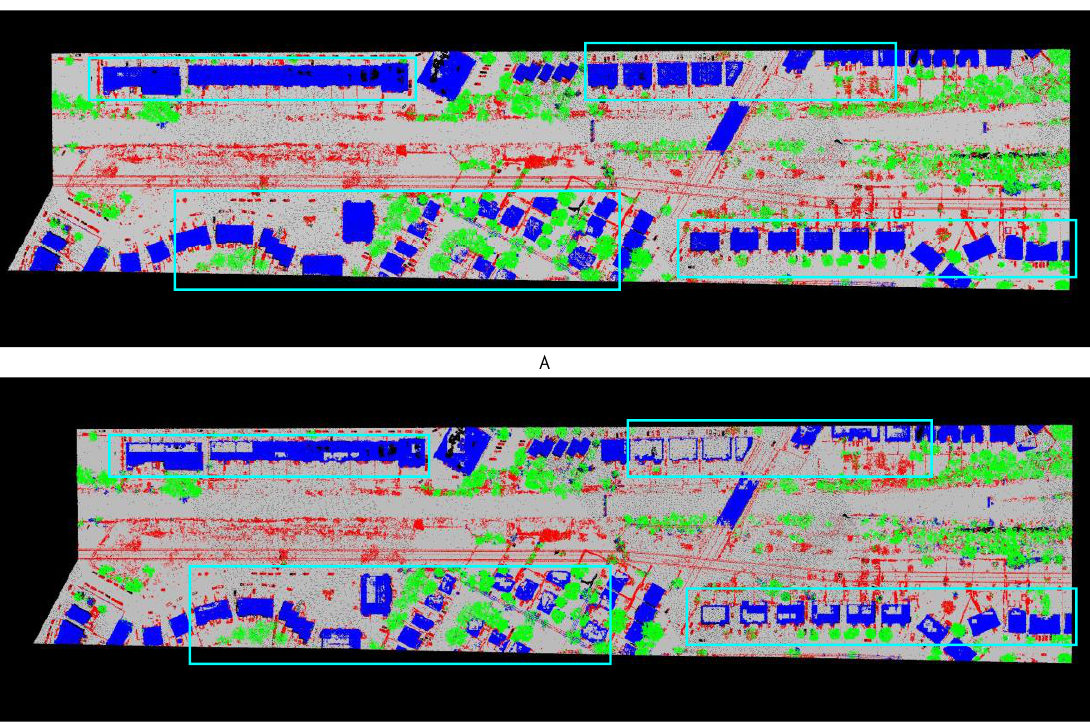
Figure 8. Comparison of semantic segmentation results of airborne LiDAR point cloud. (A) our result and (B) result based on features in (Hackel,